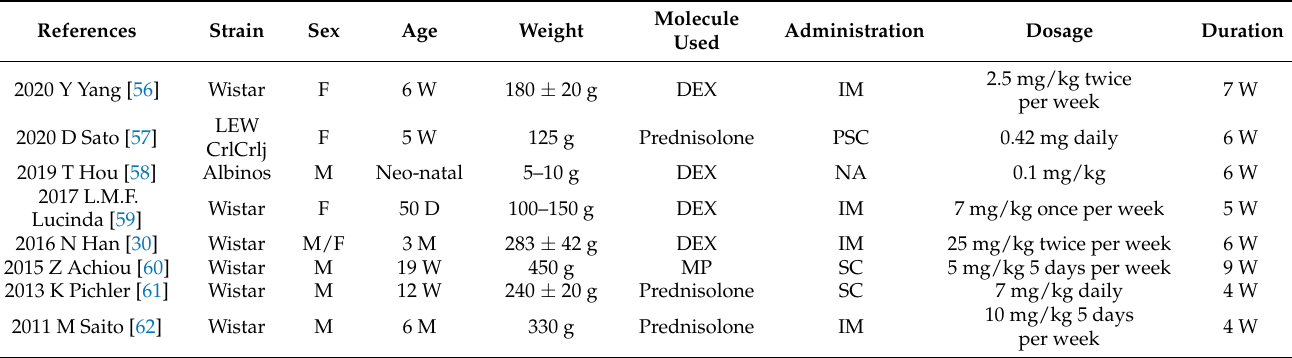
Table 5. Main characteristics of the proposed experimental protocol to induce GIOP in male and female rats (excluding Sprague Dawley). M = Male, F = Female, DEX = Dexamethasone, MP = Methylprednisolone, IM = Intramuscular injection, SC = Subcutaneous injection, PSC = Pellet in Subcutaneous, NA = Not Available.